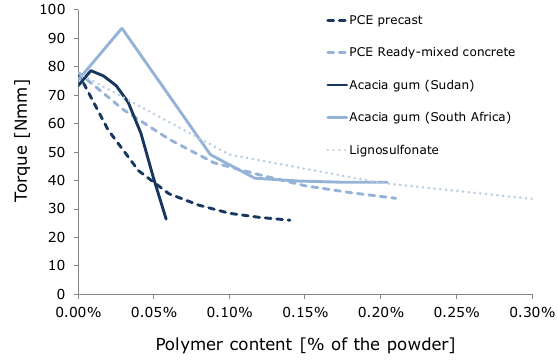
Figure 3. Torque evolution depending on admixture dosage.